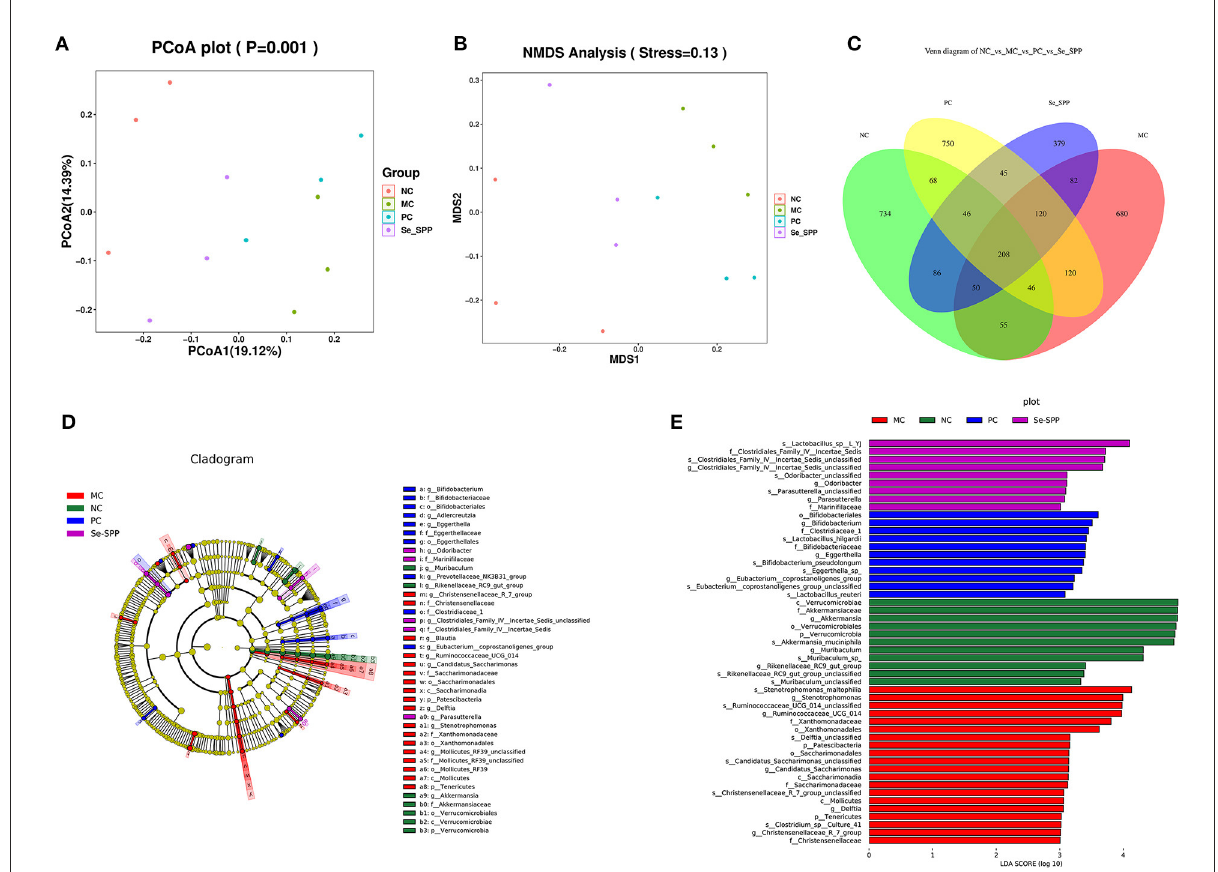
FIGURE5 Se-SPP modulates the specific phylotypes of the gut microbiome. β -Diversity representing PCoA and NMDS (A,B) , Venn diagram of OTUs (C) , and cladogram. From the inside out was the bacterial taxonomic level of phylum, class, order, family, and genus (D) , indicator bacteria of intestinal microbiota with LDA scores of 3 or greater in mice (E) . NC, normal control; MC, model control; PC, positive control; Se-SPP, selenium-containing polysaccharides from Spirulina platensis . Data are expressed as mean ± SEM ( n =